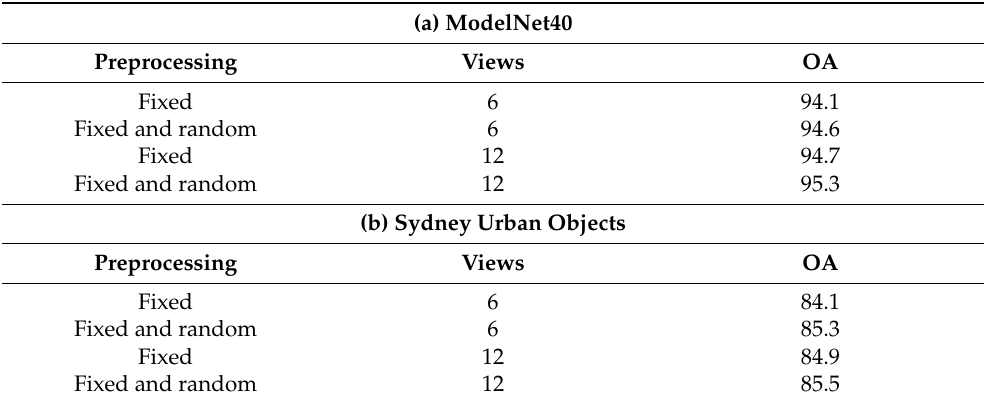
Table 3. Comparison of the classification performance of different viewpoint selection methods. (a)